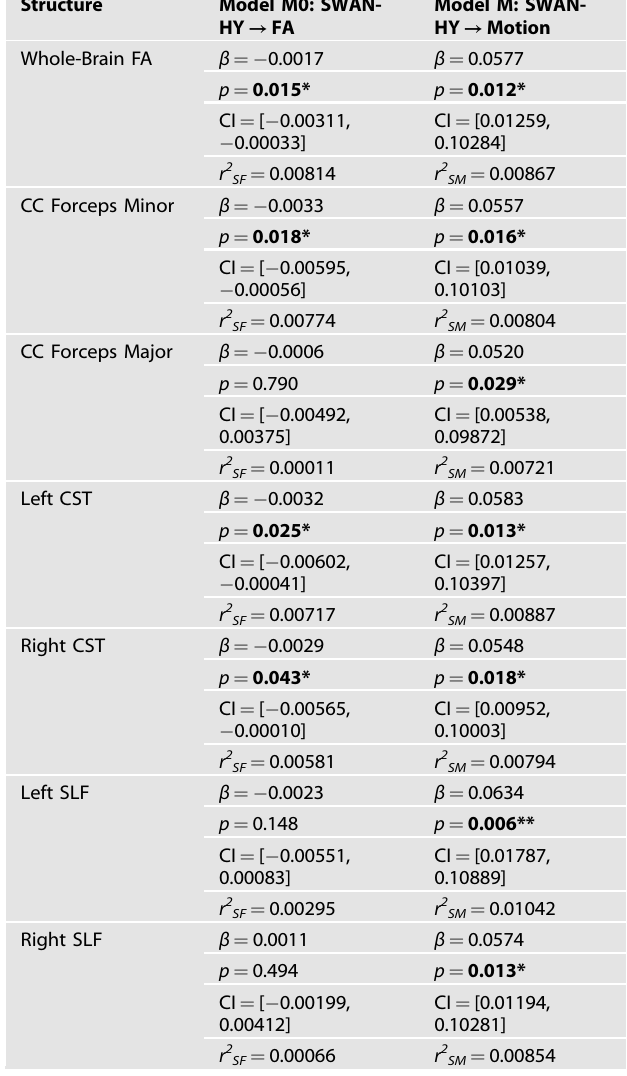
Table 2. Summary of regressions of Models M0 and M as premise for causal mediation analysis using the dimensional model.